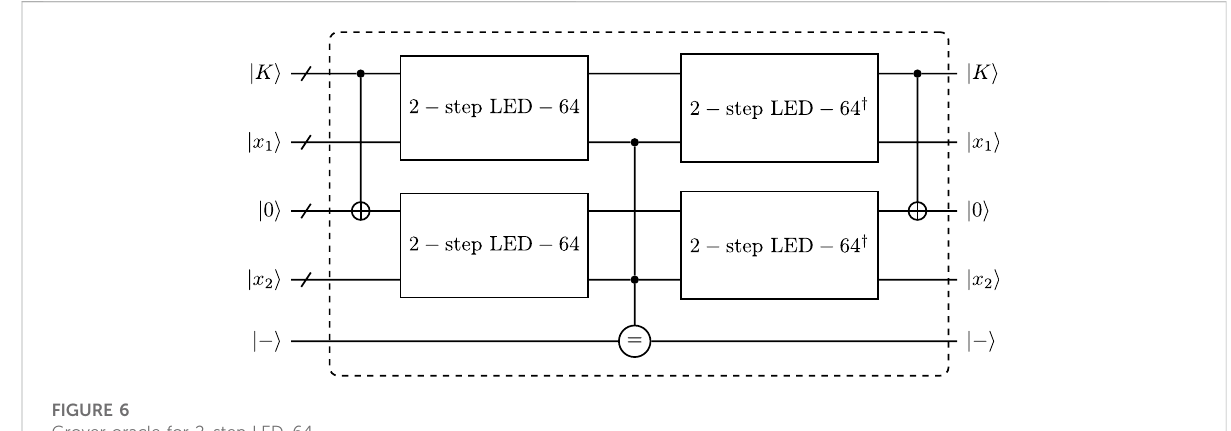
FIGURE 6 Grover oracle for 2-step LED-64.